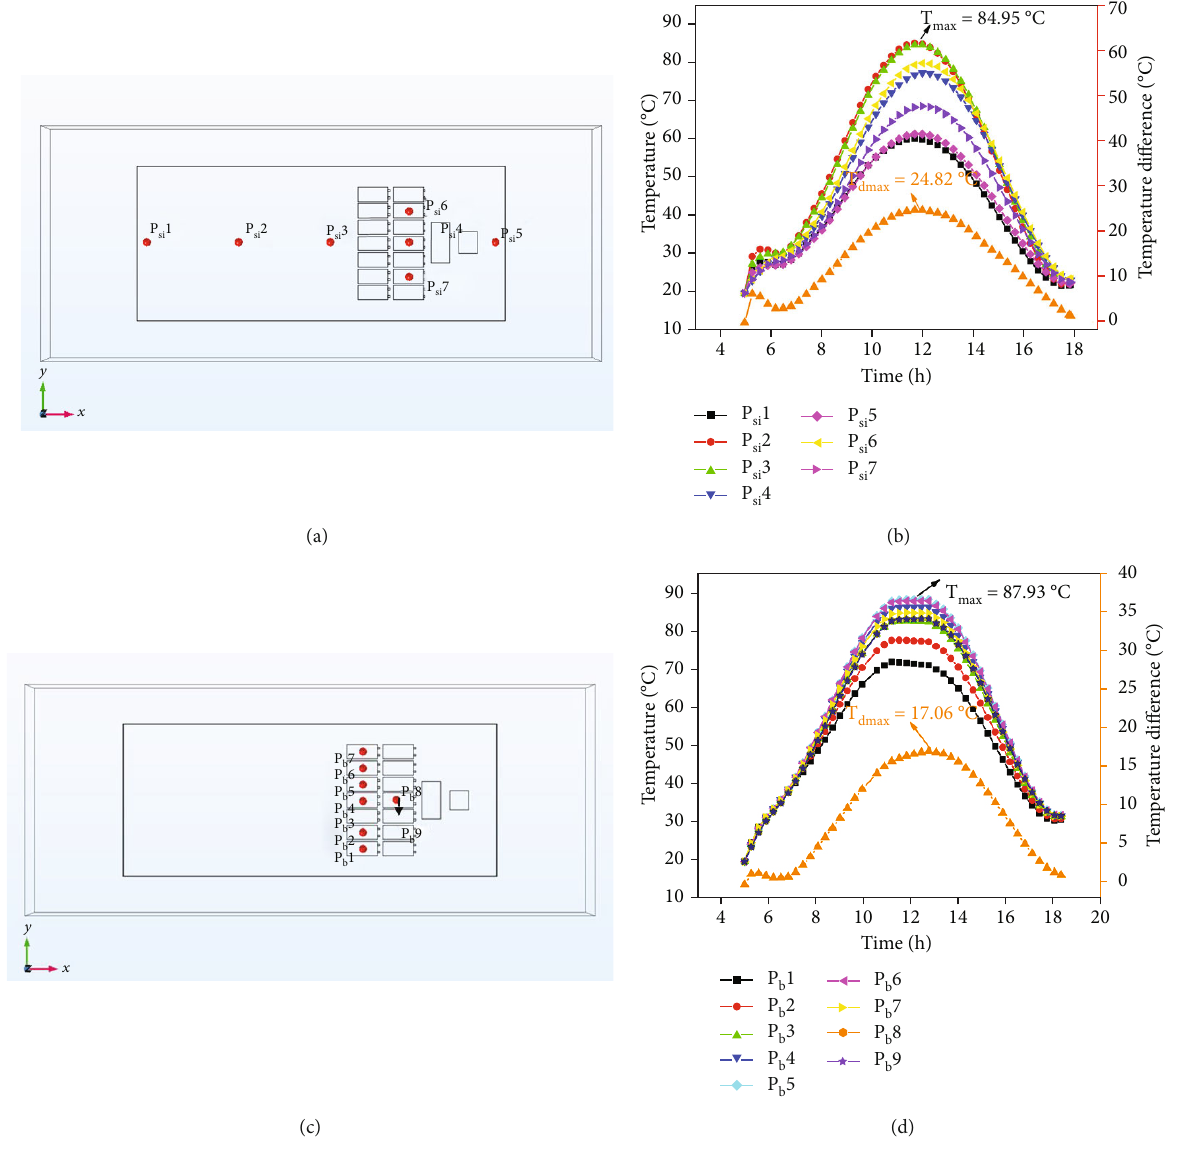
Figure 9: Schematic and measuring results of G – PBIS: (a) detection point diagram of silicon layer in G – PBIS, (b) temperature variations of silicon layer in G – PBIS, (c) detection points distribution of batteries in G – PBIS, and (d) temperature variations of batteries in G –